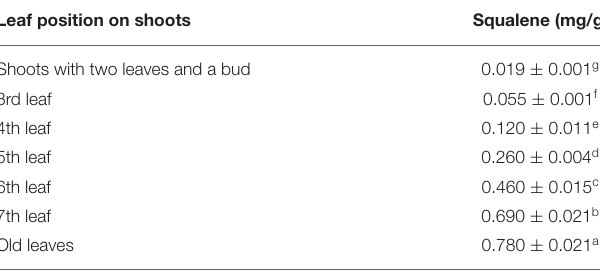
* : Data with different lowercase alphabetic letters were significantly different at p <